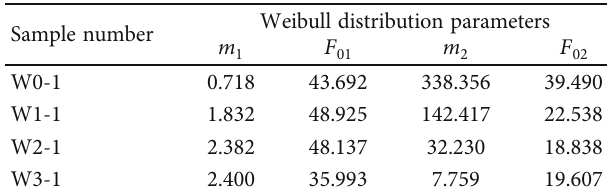
/ M Þ relationship and (b) relationship between fractal dimension and moisture d Table 3: Parameters of rock sample